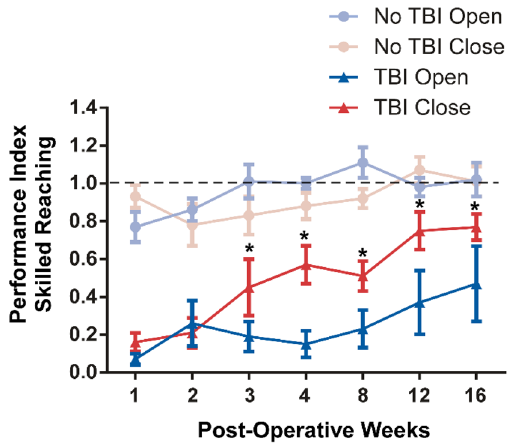
Figure 4. Early cranial repair was beneficial to recovery of motor skills following TBI. Cranial repair improved performance for rats with TBI (TBI Closed Skull Group) beginning 3 weeks after injury. The TBI Closed Group continued to perform better than the TBI rats with open cranium (TBI Open Skull Group) on subsequent assessment days through 16 weeks of recovery. There were no significant differences in performance between the non-injured groups (No TBI Closed Skull Group vs. No TBI Open Skull Group) throughout the 16-week assessment period . The horizontal dash line represents a standard index of pre-injury baseline that equals 1 for each animal: pre-surgical success/post-surgical success. Scores under the dashed line indicates motor impairment. The asterisk ‘*’ indicates a group comparison that is statistically significant. P values were derived from post-hoc analysis of the Group by Time effect using Fisher’s protected